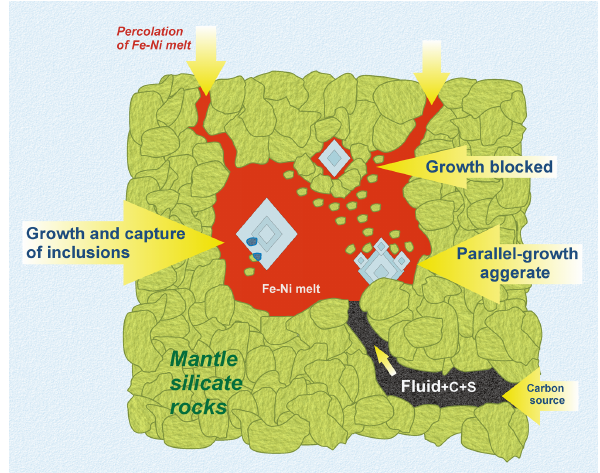
Figure 8. Scheme illustrating the growth of diamond crystals in metal melt pocket. Percolation of the Fe–Ni metal through silicate rock in the mantle (shown with arrows in the upper part) forms the metal pocket. Fluid could act as a transporter of carbon and other light elements, like sulfur, to the pocket. High-quality large diamond crystals can grow in the volume of the metal melt that is almost silicate-free (large crystal on the left); rare inclusions of silicate minerals, which are present together with diamond in the metal melt, can be captured by the crystal. Parallel-growth aggre- gates of diamond can form when there are many silicate phases in the metal around the growing diamond (crystal at the bottom). Dia- mond growth is completely interrupted by silicate minerals floating in the metal melt – such case is most likely to occur in the upper part of the pocket (small crystal at the